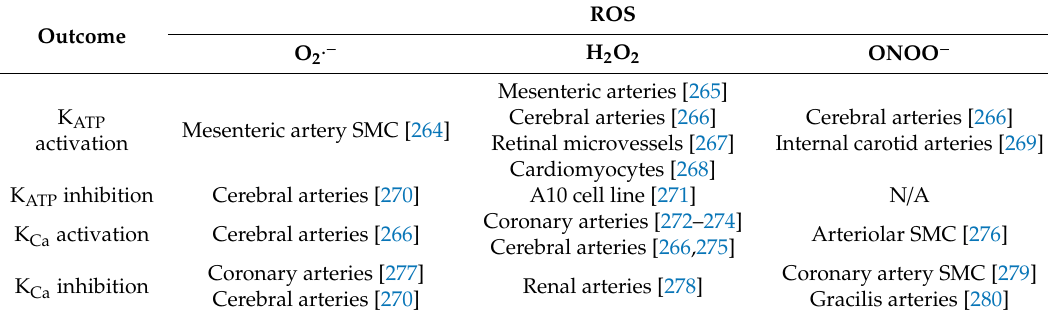
Table 5. ROS modulation of K ATP and K Ca channels in cardiovascular